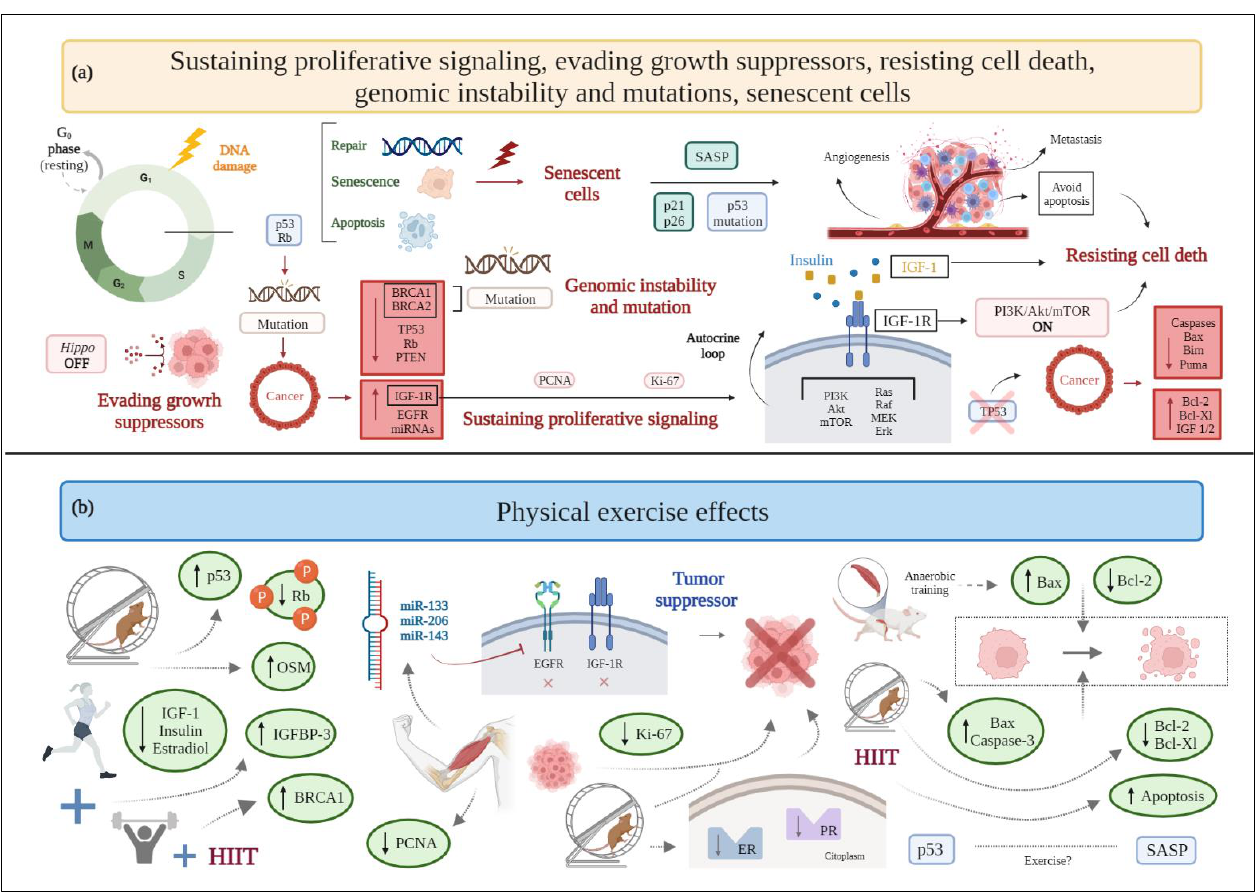
Figure 1. ( a ) Schematic drawing of cancer hallmarks, highlighting markers related to sustaining proliferative signaling, evading growth suppressors, resisting cell death, genomic instability, and senescent cells. ( b ) The effects of physical exercise on sustaining proliferative signaling, evading growth suppressors, resisting cell death, genomic instability, and senescent cells. Abbreviations: Akt: protein kinase b; BRCA1: breast cancer type 1; BRCA2: breast cancer type 2; EGFR: epidermal growth factor receptor; ER: estrogen receptor; Erk: extracellular signal regulated kinase; HIIT, high-intensity interval training; IGF-1: insulin-like growth factor 1; IGF-1R: insulin-like growth factor receptor type 1; IGFBP-3: insulin-like growth factor binding protein-3; miRNA: microRNA; MEK: mitogen activated protein kinase; mTOR: mammalian target of rapamycin; OSM: oncostatin M; PCNA: proliferating cell nuclear antigen; PI3K: phosphatidylinositol-3-kinase; PR: progesterone receptor; PTEN: phosphatase and tensin homolog; Rb: retinoblastoma; SASP: senescence-associated secretory phenotype; TP53: tumor protein 53.